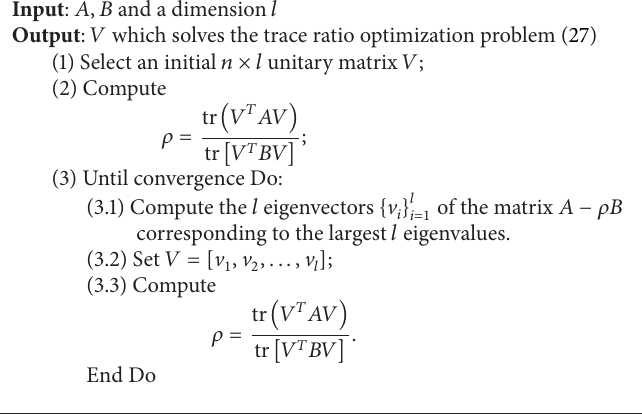
Algorithm 3: Newton’s method for trace ratio optimization.